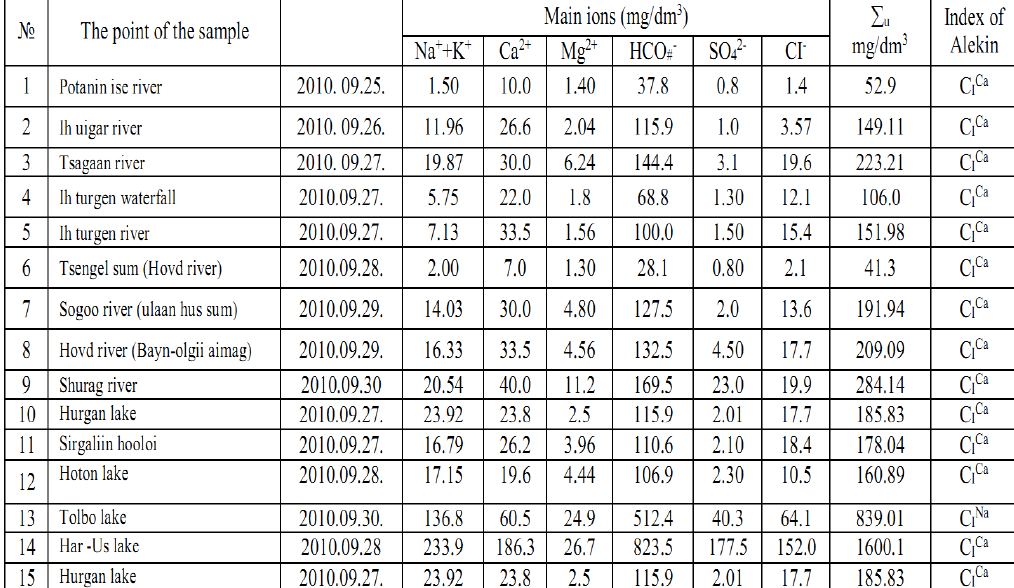
Table 1. Chemical composition of Hovd river and water its river